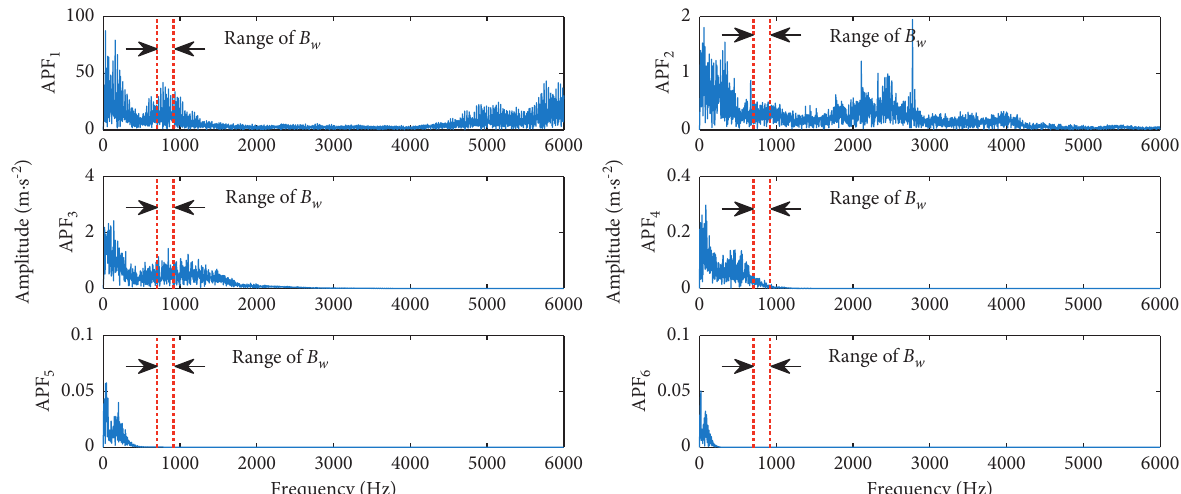
Figure 6: Calculated PF components with the reinforced ELMD algorithm for the benchmark